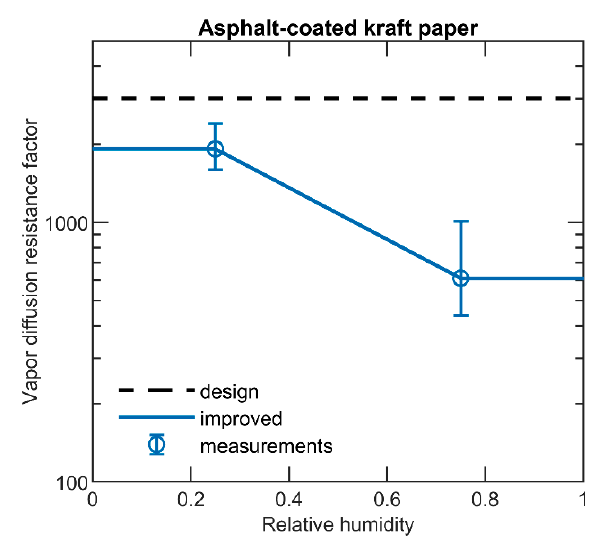
Figure 6. Water vapor diffusion resistance factor measurements and improved model for kraft paper.